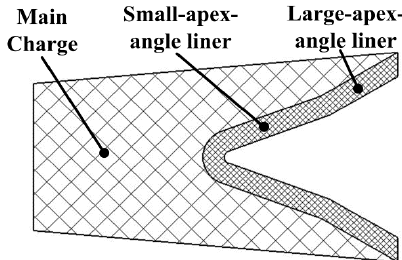
Figure 1. Schematic of a bi-apex-angle linear shaped charge (BLSC).